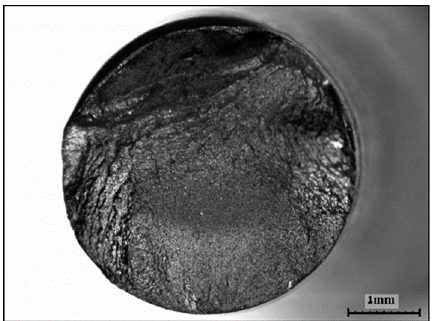
Figure 8. Fractography analysis of ST-37 alloy after high cycle fatigue failure in air, with 240 MPa load and 3,554,000 cycles.